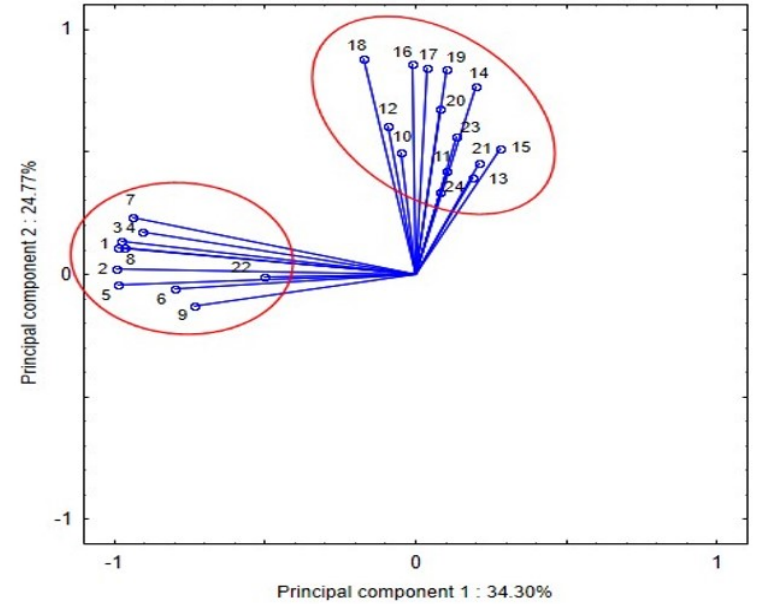
Figure 1. Projection of the components on the principal components plane (1—protein, 2—isoleucine,